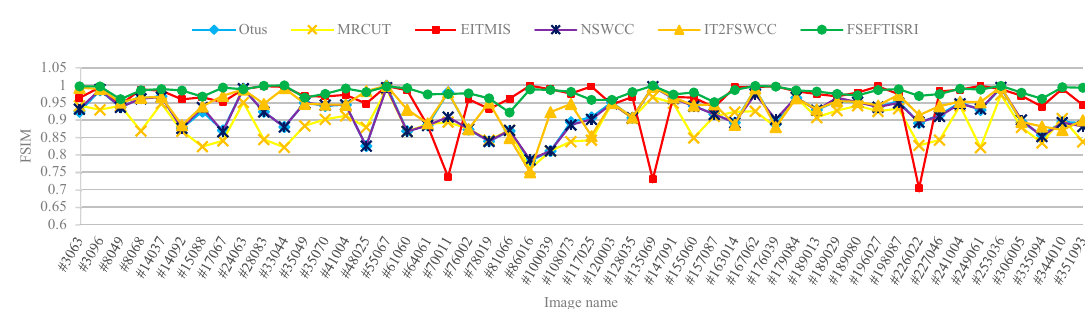
Figure 17. Comparison of ME of several algorithms.